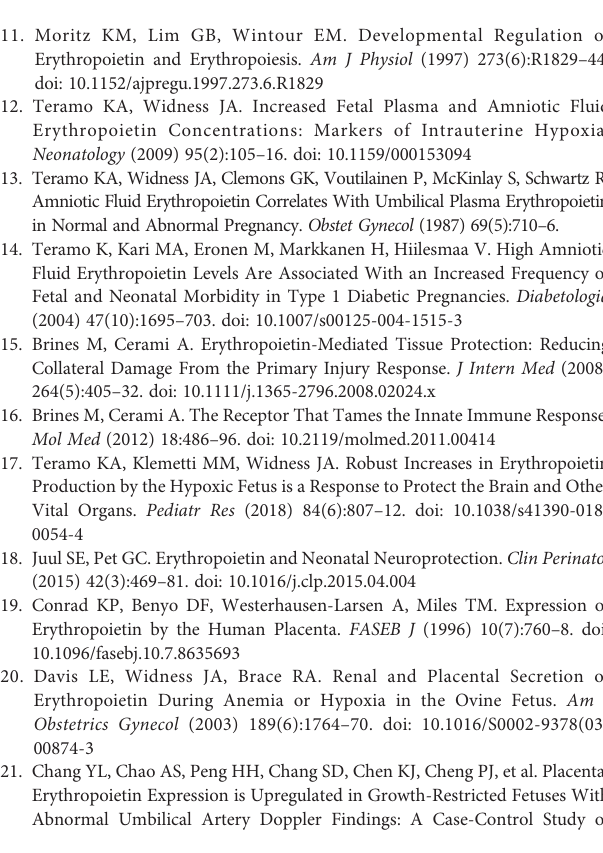
Supplementary Figure 1 | A diagram representing the formation of the study population. Offspring of women with type 1 diabetes (OT1D); amniotic fl uid erythropoietin (AF EPO); OT1D with low AF EPO <14.0 mU/ml (L-EPO); OT1D with high AF EPO ≥ 14.0 mU/ml